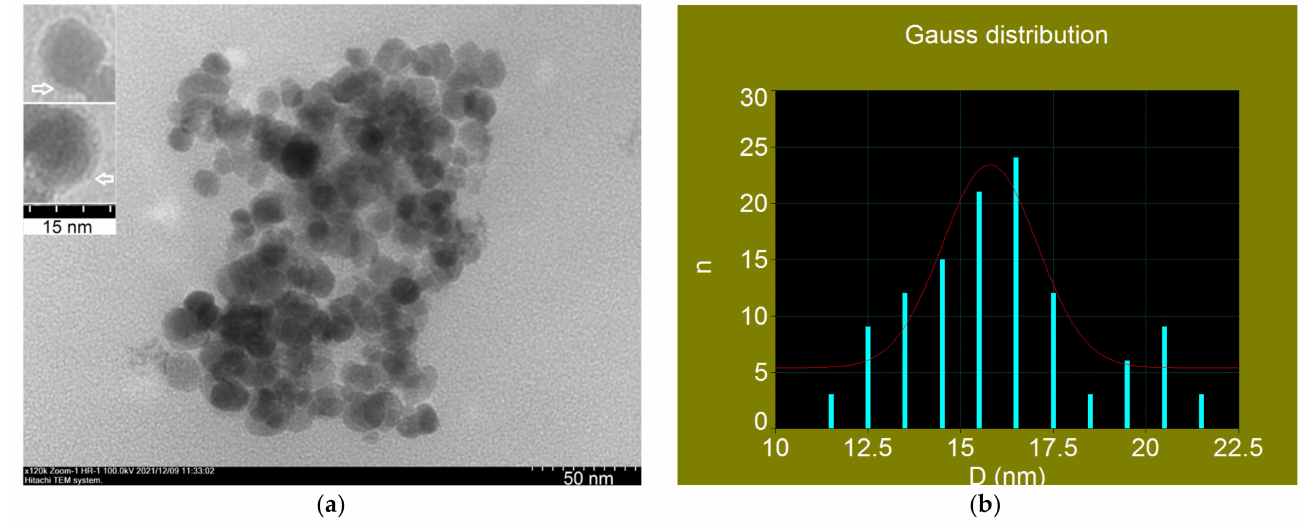
Figure 8. ( a ) TEM image with HR-TEM image inset (the arrow marks the PAA layer on the surface of nanoparticles), and ( b ) histogram (blue bar) and distribution function (red curve) of Fe 3 O 4 - PAA